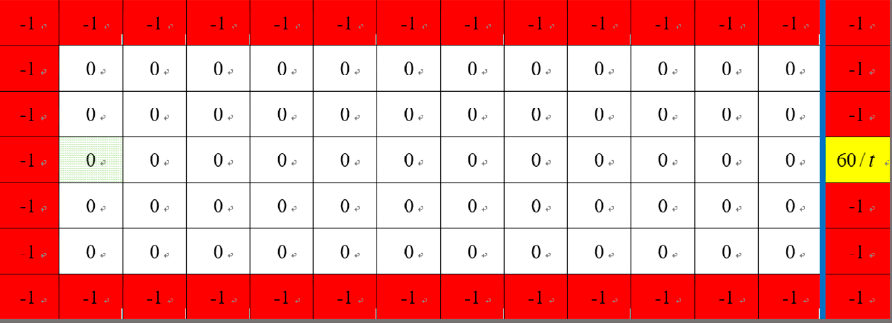
Figure 19. Reward description of the Q-learning algorithm in the training field.